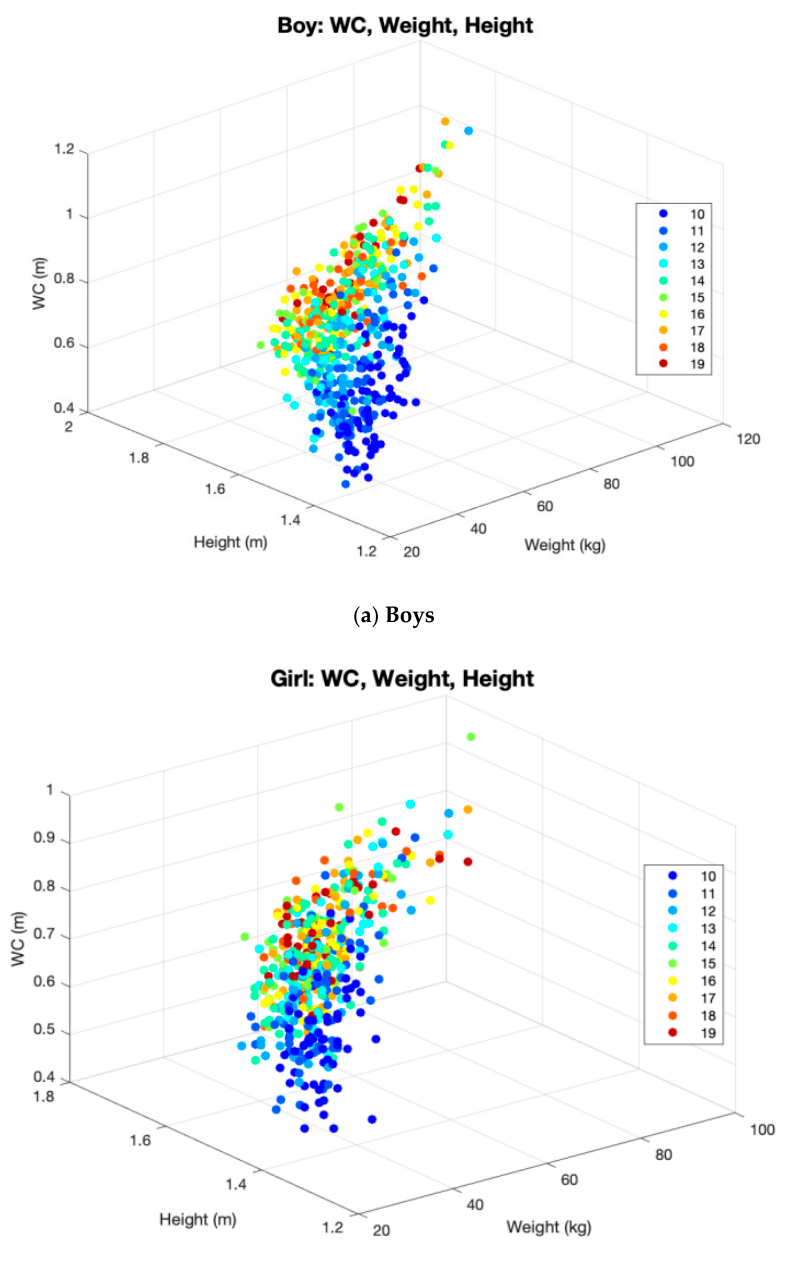
Figure 3. Scatter plot of the relationships among height, weight, and WC according to age in boys and girls. WC waist circumference.